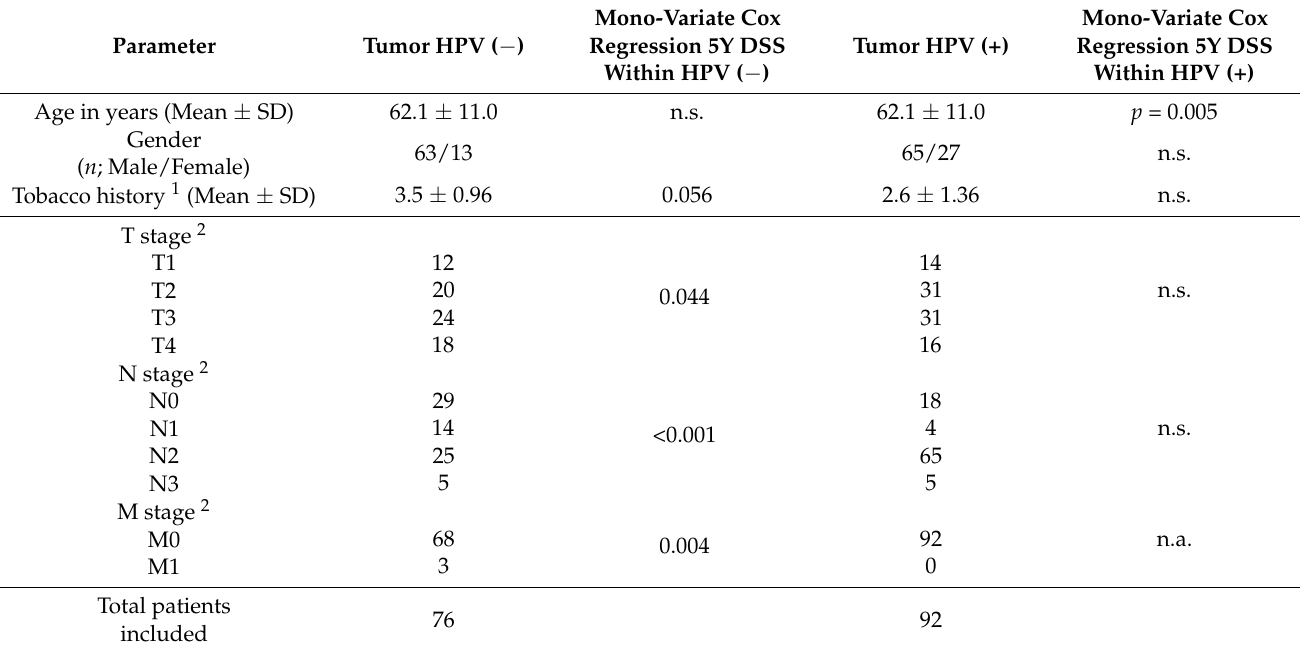
Table 1. Clinical patient characteristics including patient age at diagnosis, site of tumor, smoking history, T and N stage as well as their mono-variate five-year disease-specific survival (DSS) all reported by HPV status (unknown for two